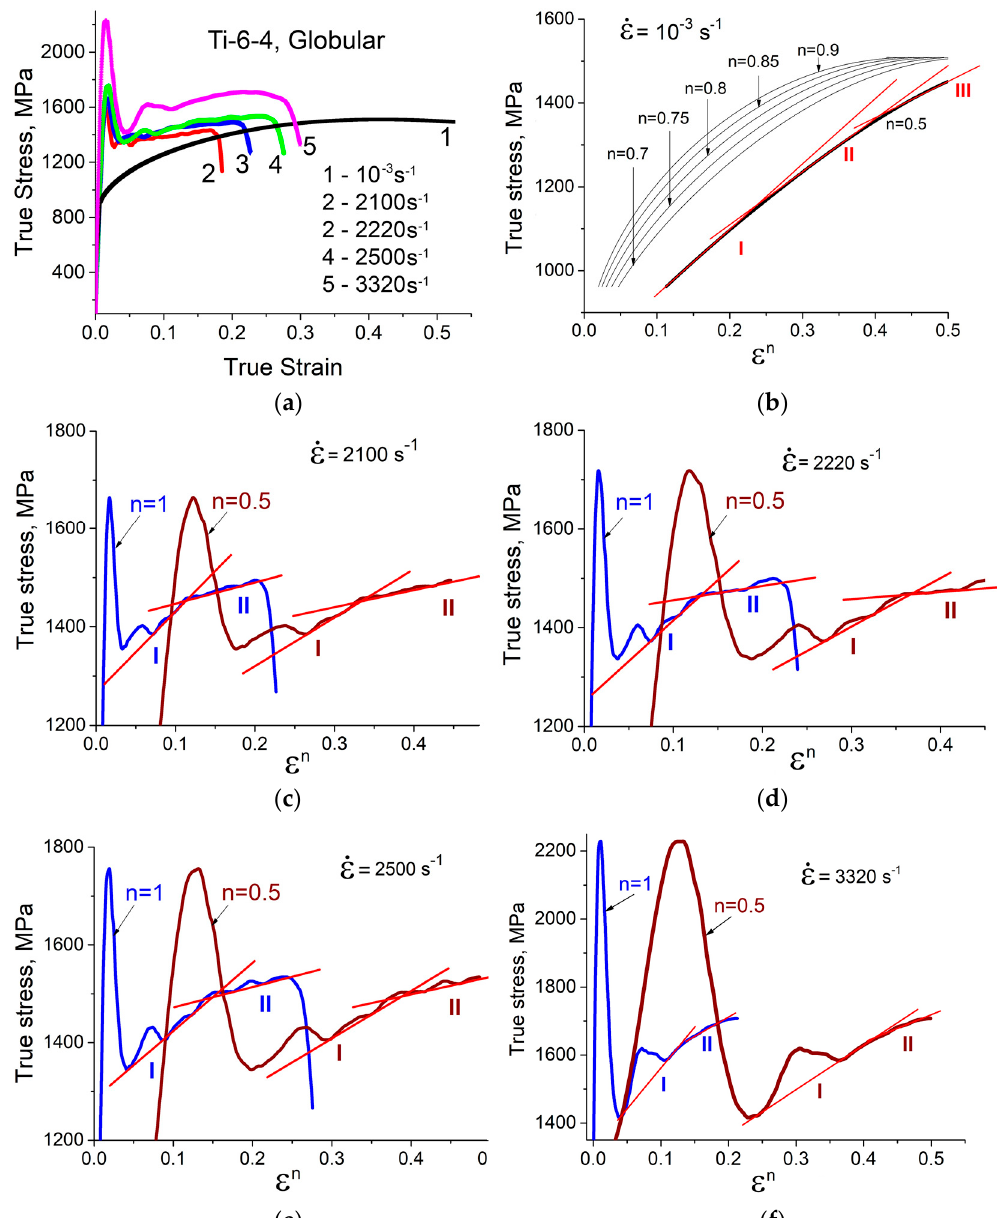
Figure 2. True stress-trues strain curves for Ti64GL specimen compression tested with the different strain rates ( a ); Analysis of stress-strain curves for: ( b )—quasi-static compression with rate 10 − 3 s − 1 , and high strain rate SHPB tests with rates ( c )—2100 s − 1 , ( d )—2220 s − 1 , ( e )—2500 s − 1 , and ( f )—3320 s − 1 .